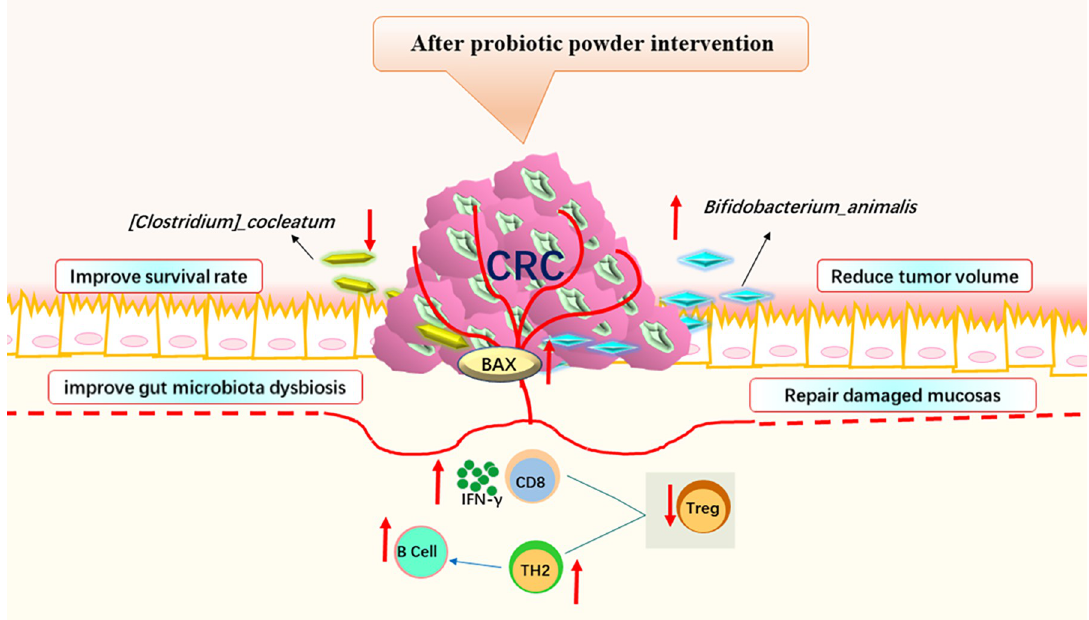
Fig 7. Schematic diagram of the function of the probiotic powder in CRC. The probiotic powder ameliorated CRC by regulating the gut microbiota (increased the abundance of Bifidobacterium animalis and reduced the abundance of Clostridium cocleatum ), attenuating CD4 + Foxp3 + Treg cells, promoting the number of IFN- γ + CD8 + T cells, increasing Th2 cell abundance and B cell abundance in the immune microenvironment of CRC, resulting in increased expression of BAX in